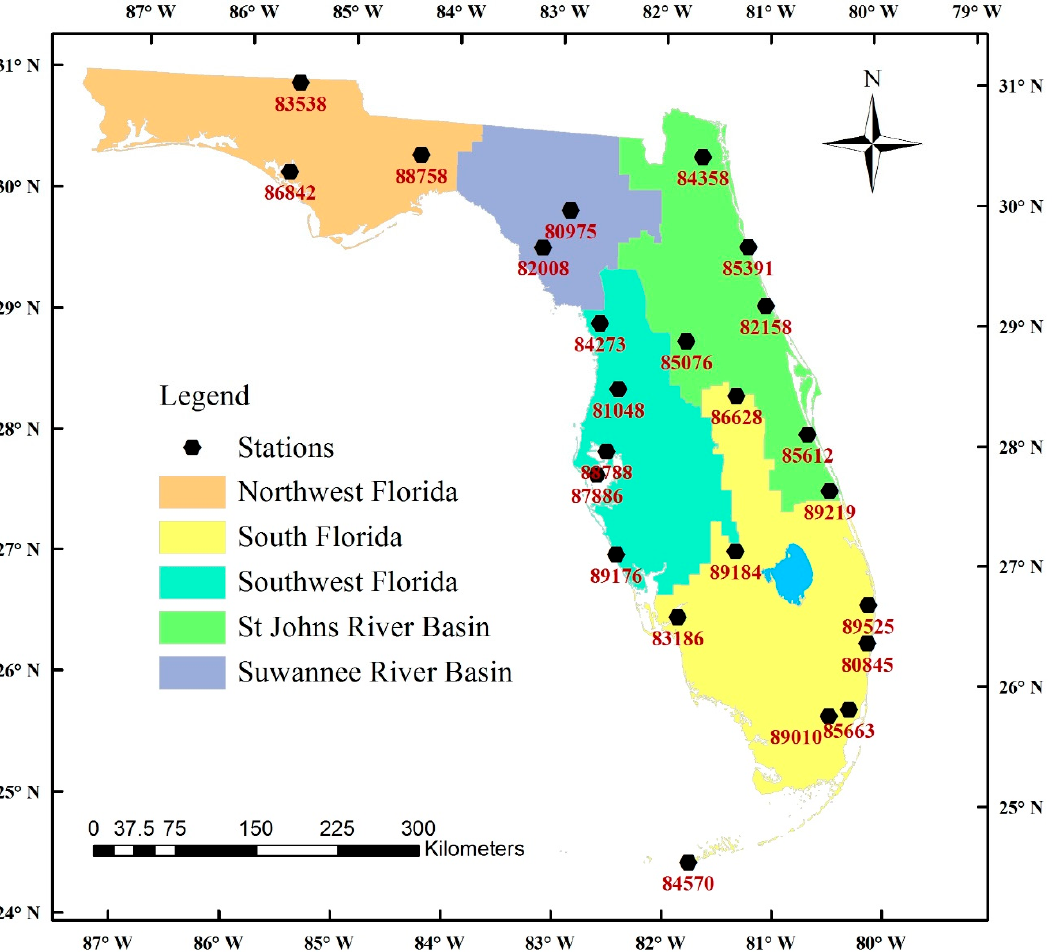
Figure 1. Study area map indicating the stations used for long-term precipitation trend analysis. Number below the station indicates the COOP ID provided by the U.S. National Climatic Data Center.